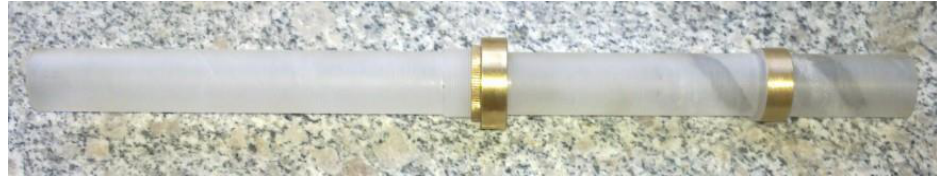
Figure 9. Multiphase flow device of DGLS structure experimental prototype.